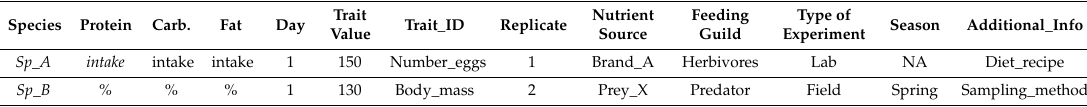
Table A1. Excel (.csv) template for sharing GFN raw